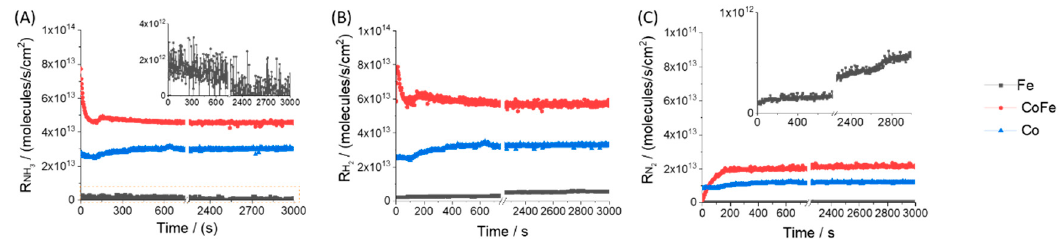
Figure 3. Flow regime step-transient data during ammonia decomposition at 550 °C. Ammonia feed is switched on at time = 0 s. Gas phase reaction rate data for ( A ) ammonia, ( B ) hydrogen and ( C ) nitrogen as a function of time. Note the break in the time scale to distinguish the transient regime from the approach to steady-state. The inset shows trends in performance on the iron sample which was generally an order or magnitude lower.